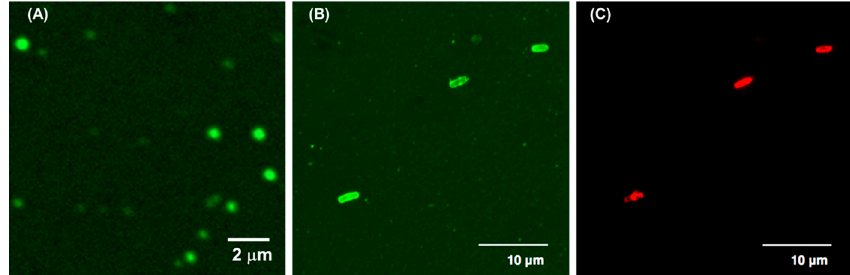
Figure 5. Confocal fluorescent microscopic images of ( A ) 50 μ g/mL solution of B38 26 containing F-B38 26 (FITC: 5.3 mol %) in HEPES buffer, ( B ) E. coli (OD 600 ~ 0.05) incubated with 100 μ g/mL solutions of B38 26 containing F-B38 26 and ( C ) PI (1.6 μ M) in HEPES buffer (0.5% DMSO). The images are projected images of 42 image stacks acquired with a z-step of 0.1 μ m (total height: 4.2 μ m).